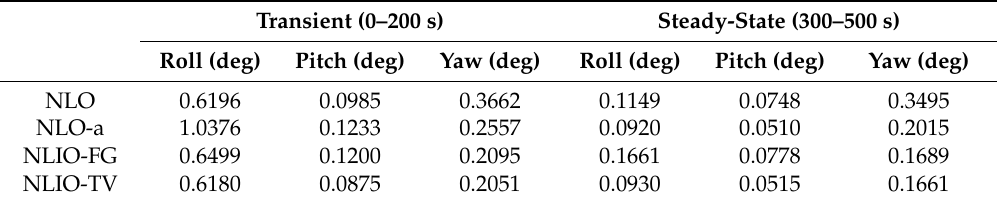
Figure 5. Averaged absolute gyro bias estimation errors over 100 simulations for Case 1. Table 1. MAEs of attitude for all the nonlinear observers in Case 1.